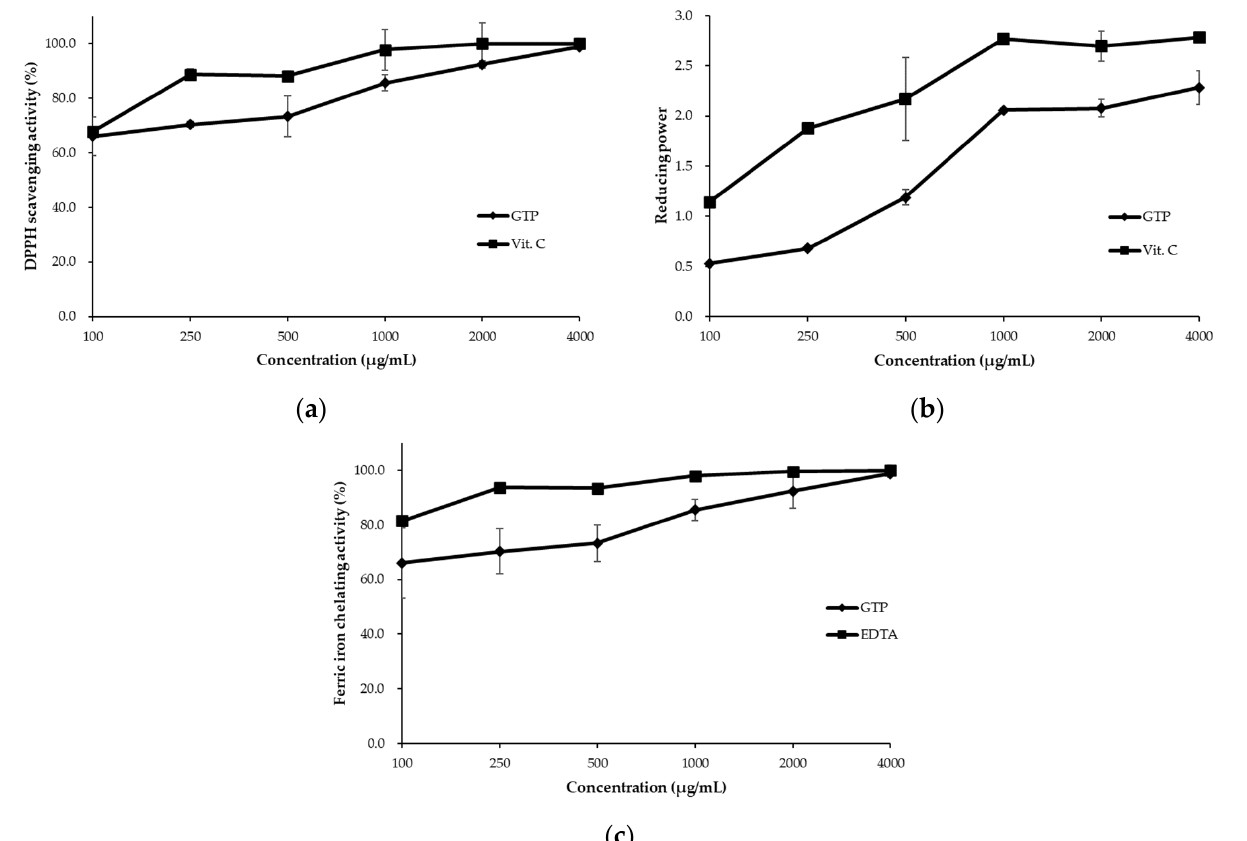
Figure 1. The free radical scavenging capacities of green tea powder (GTP), ascorbic acid (vitamin C, Vit. C), and ethylene- diaminetetraacetic acid (EDTA). ( a ) 1,1-diphenyl-2-picrylhydrazyl (DPPH) radical scavenging activity, ( b ) reducing power, and ( c ) ferric ion chelating activity of control (EDTA or Vit. C, ) and GTP ( ◆ ). Data are expressed as the mean ± SD ( n = 3).